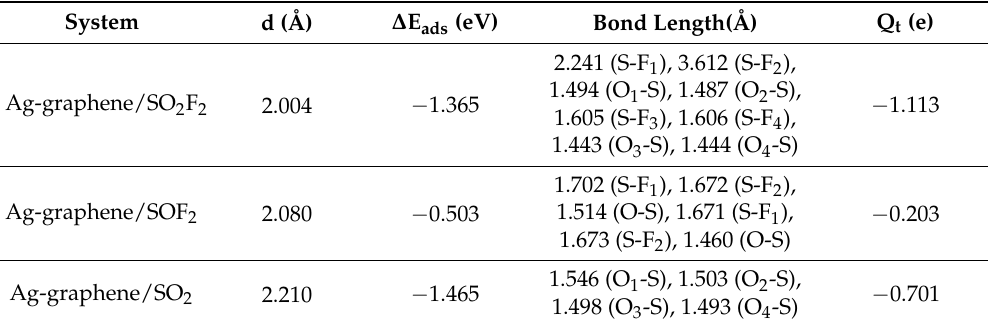
Table 5. SF 6 decomposition products adsorption on